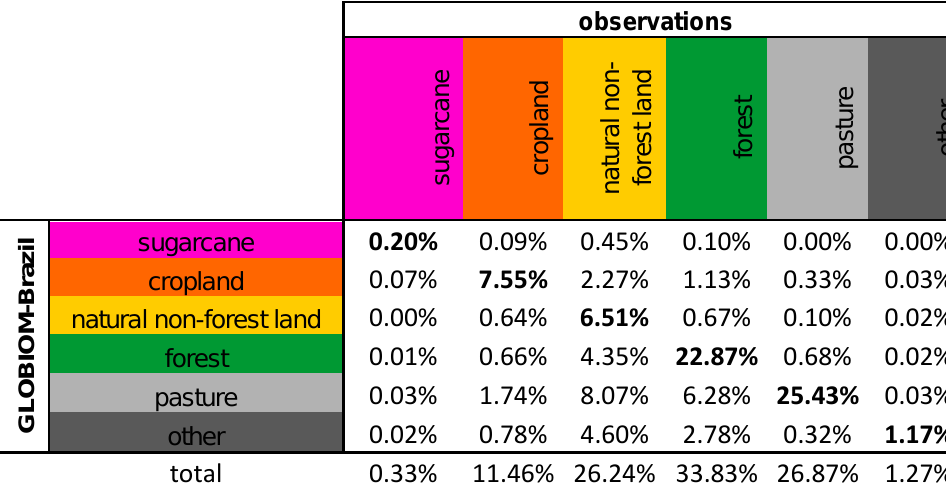
Table 3. Comparison of the modelled LU by the GLOBIOM-Brazil and the observed LU using the composite operator [36].